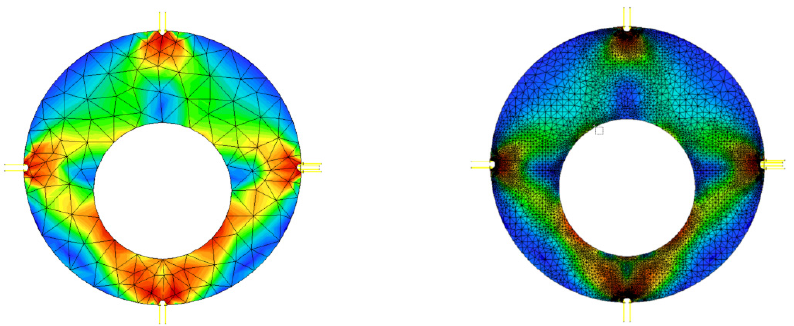
Figure 10. The numerical isochromatic fields for the initial analysis and for the final optimised mesh.